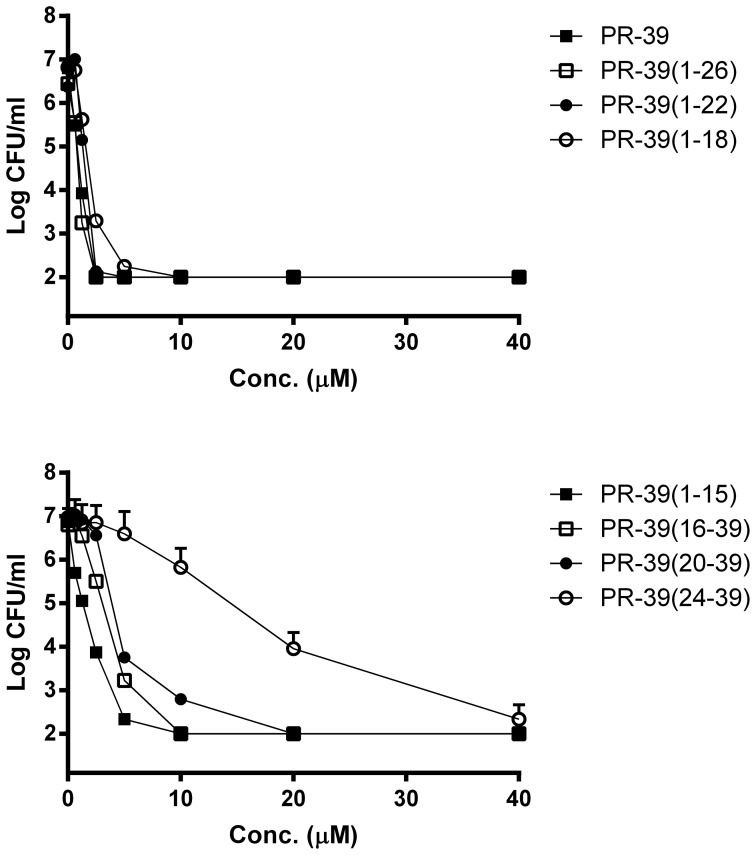
PR-39 derived peptides are active against Bacillus globigii.Peptides were incubated for 3×106 CFU/ml B. globigii in phosphate buffer (10 mM, pH 7; 1/100 TSB). Bacteria were serially diluted, plated on TSA plates and counted after 24 h. Shown are mean ± SEM of n≥3. For clarity, the data of 8 peptides is divided over 2 figures.